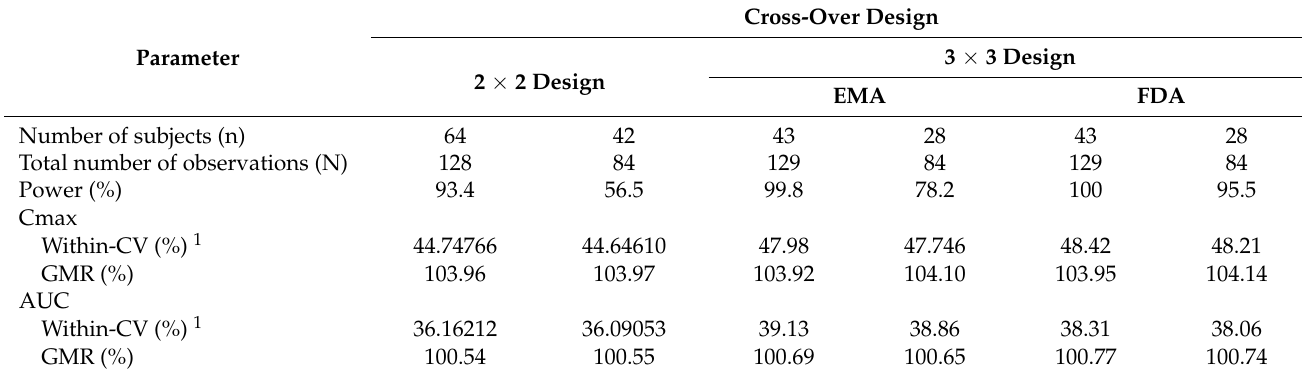
Table 2. Results of post-hoc power analysis of clopidogrel